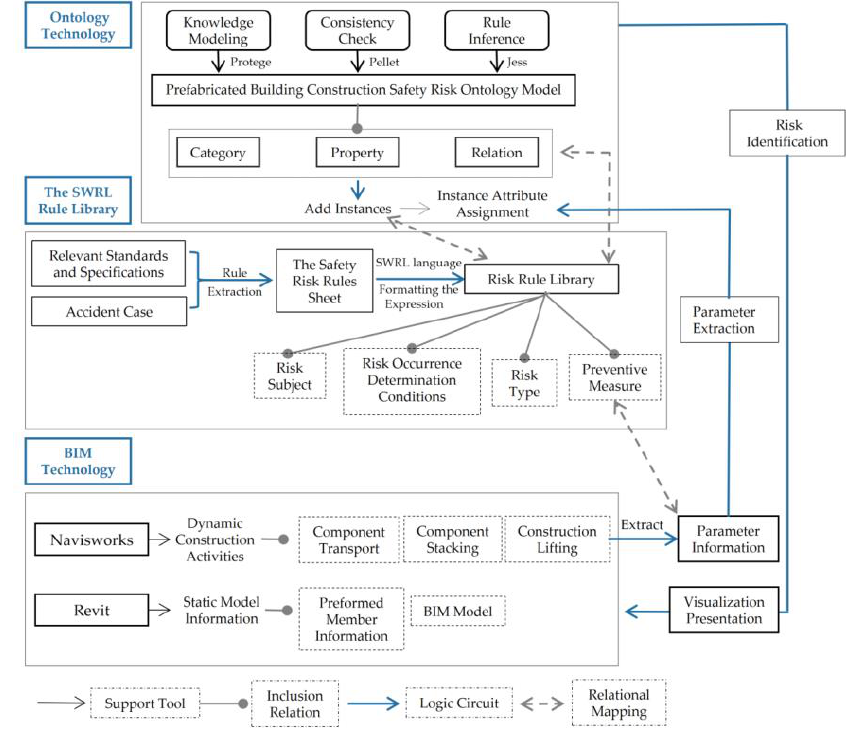
Figure 7. Logical model of the intelligent management of safety risk.